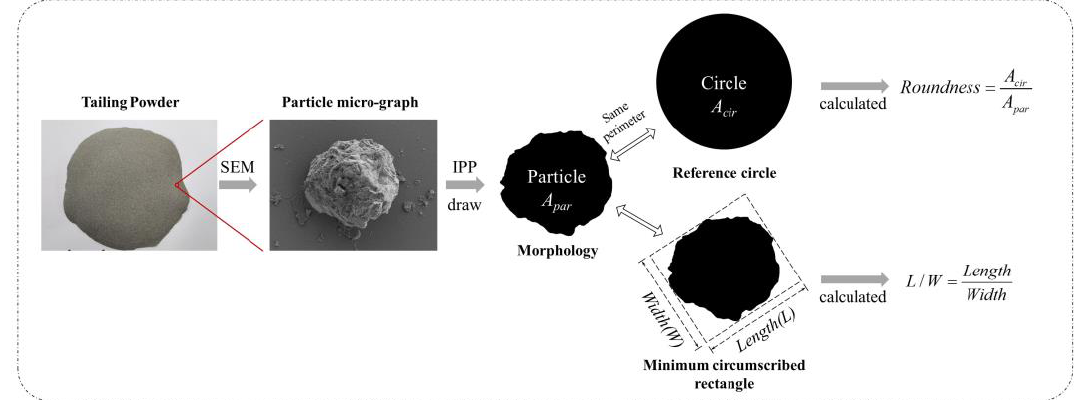
Figure 2. Schematic diagram of calculating the roundness of TP.